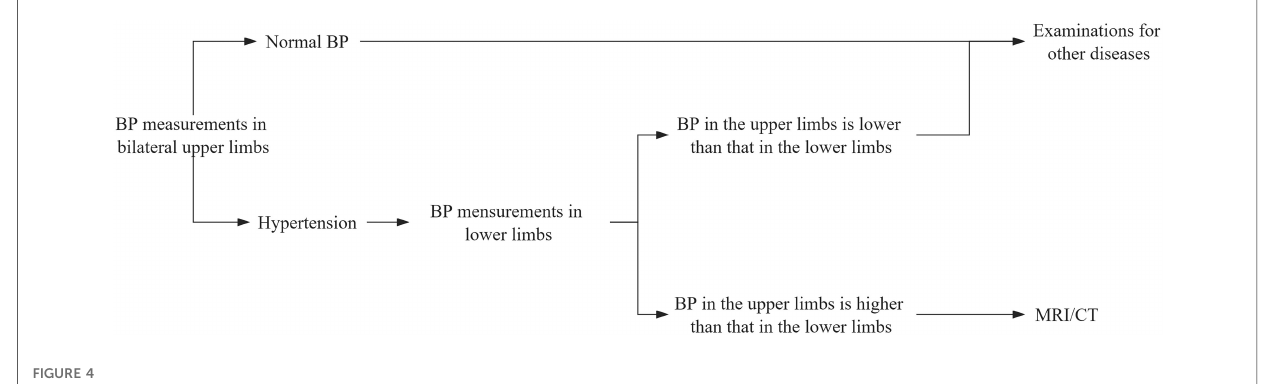
FIGURE 4 Diagnosis protocol for CoA as per our